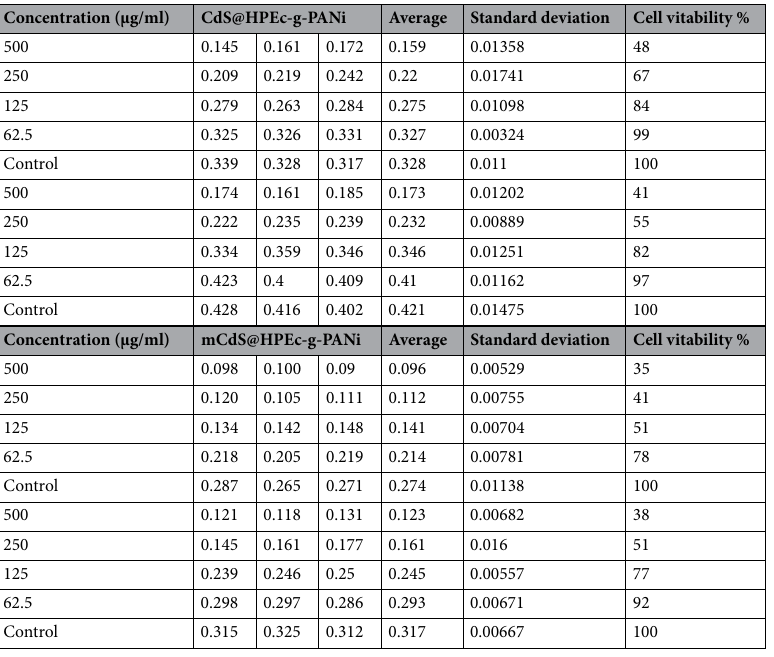
Table 3. The cell growth amounts, growth average, standard deviation and cell vitability % of the cytotoxicity results of the most effective cells, HT29 for the CdS@HPEc-g-PANi and PC3 for the mCdS@HPEc-g-PANi